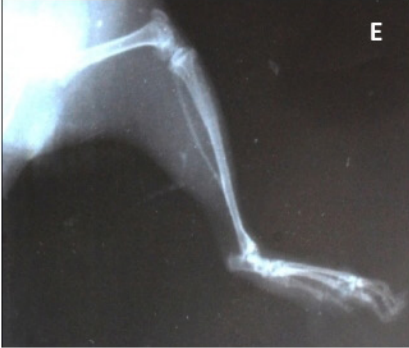
FIGURE 1 - Radiographic analysis of FCA induced arthritis in